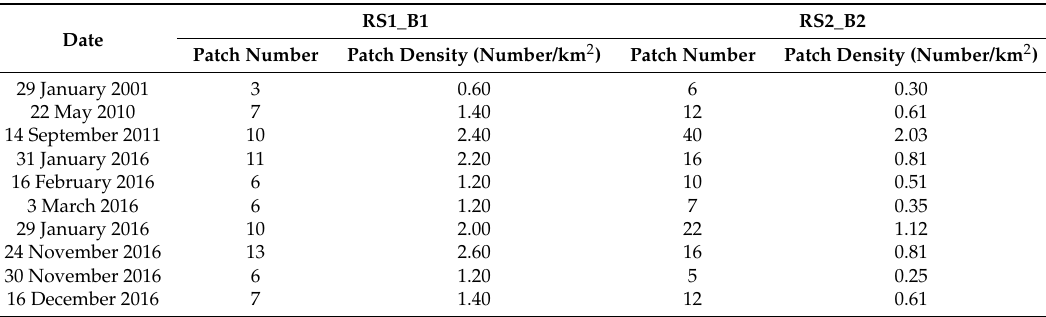
Figure 10. Changes of four landscape pattern indices in RS1_B1 and RS2_B2 during 2001–2016. Table 3. Patch number and density in RS1_B1 and RS2_B2.